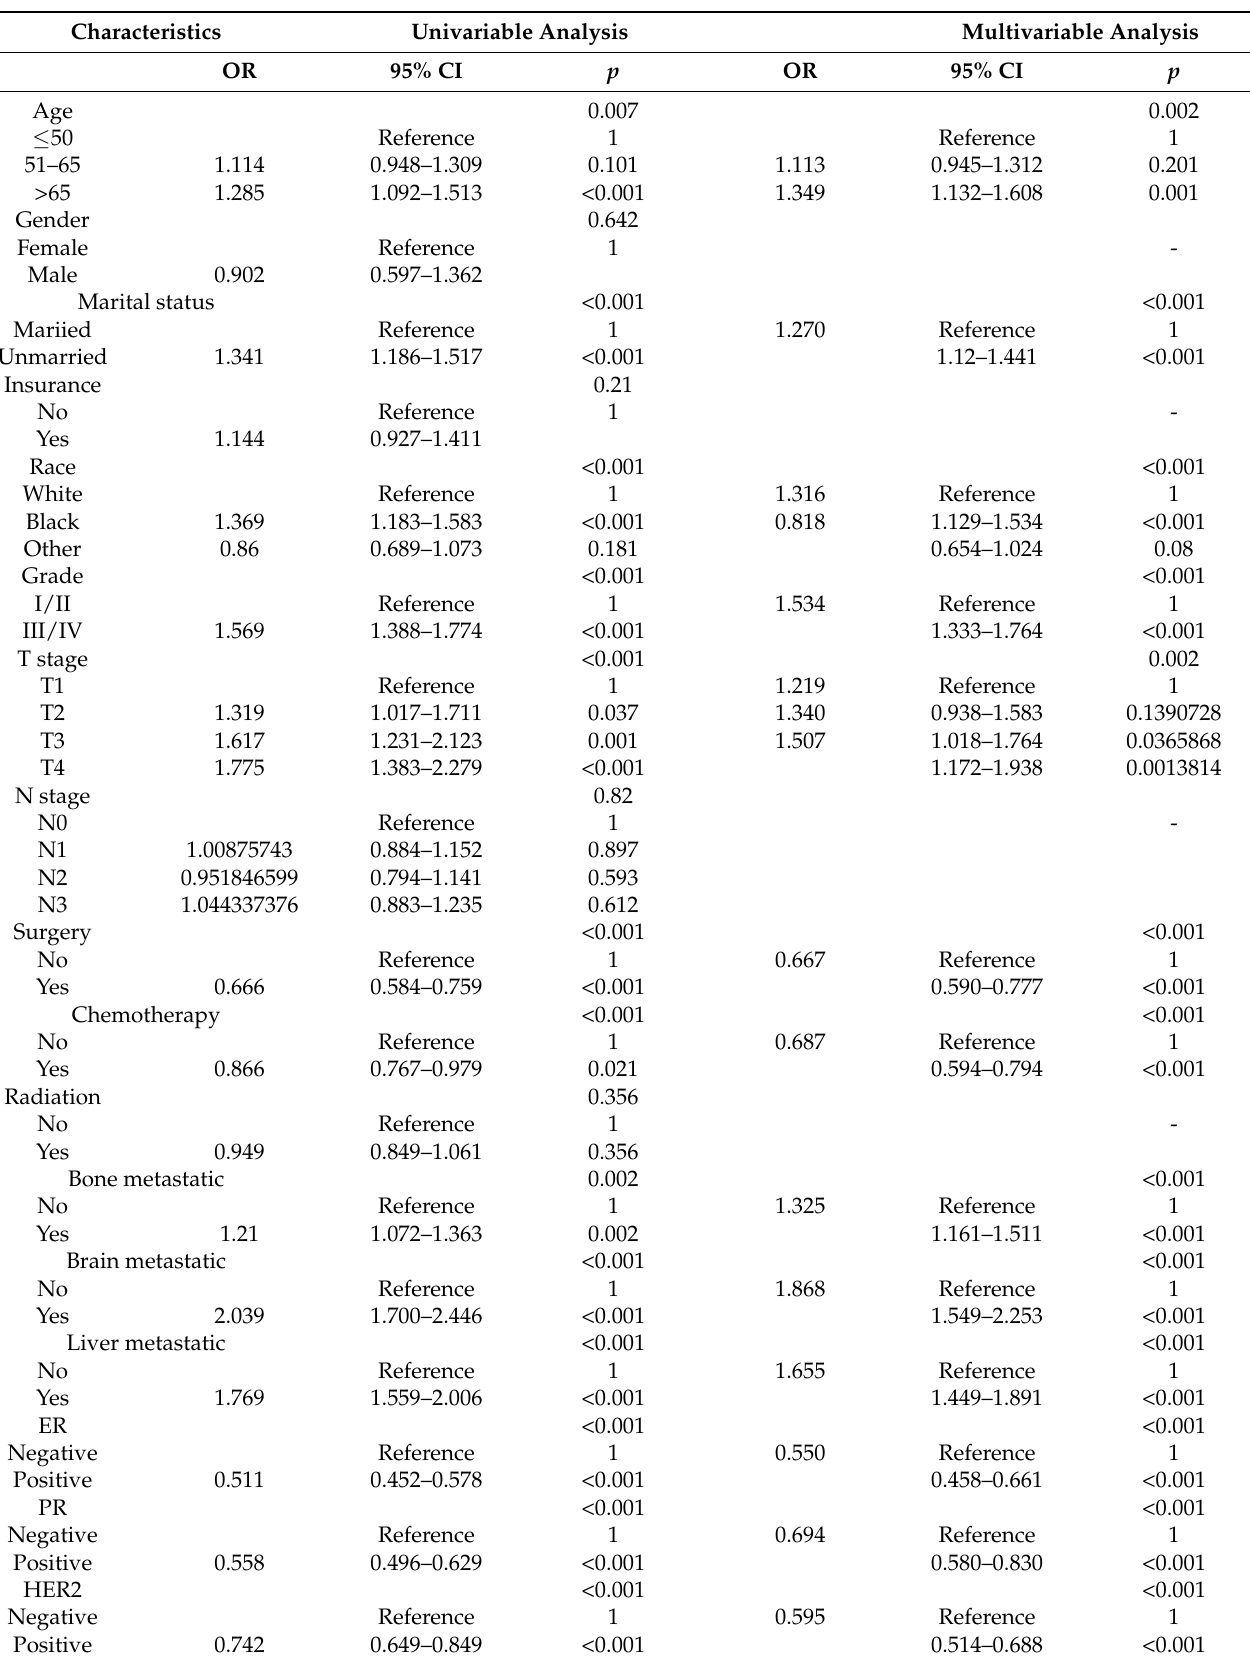
Table 3. Univariable and multivariable Cox regression model analyses of CSS for